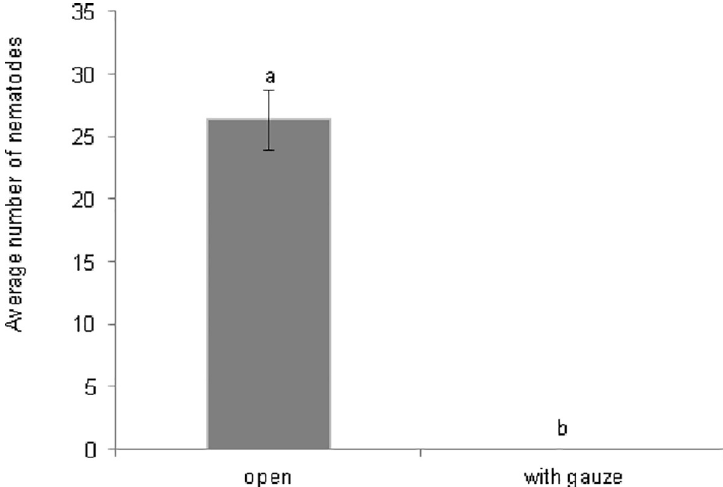
Fig 3. Average numbers of nematodes (mean ± SE) in the seawater (ca. 100 ml) in the open or gauzed (200 μ m) boxes. Letters indicate significant differences between treatments.